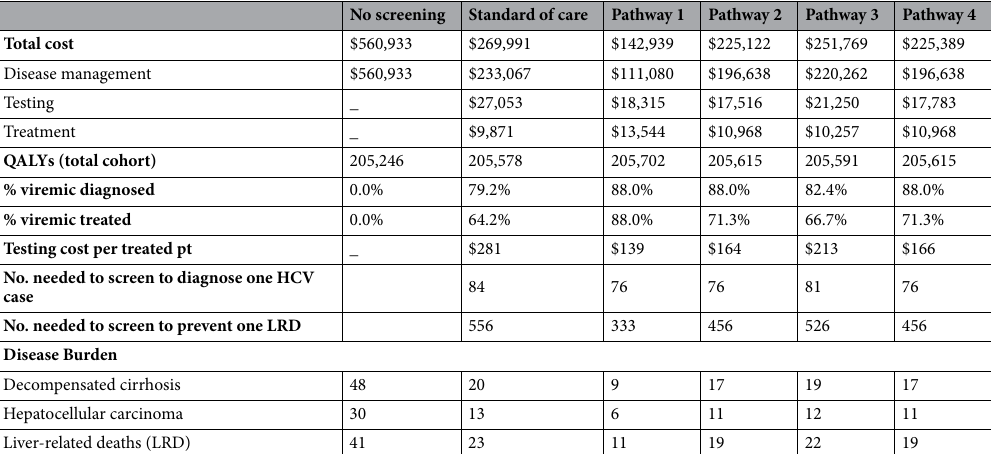
Table 3. Comparison of health-related outcomes and economic outcomes of the five screening pathways vs. no screening per 10,000 persons screened. DC decompensated cirrhosis, HCC hepatocellular carcinoma, LRD HCV-caused liver related death. *The cost for no screening represents the cost of management of HCV